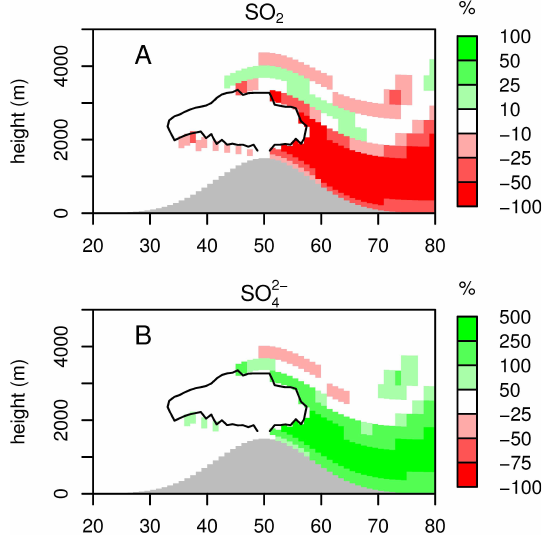
Fig. 2. Changes in gaseous SO 2 (A) and total SO 2 − mass as percent change against the reference simulation.